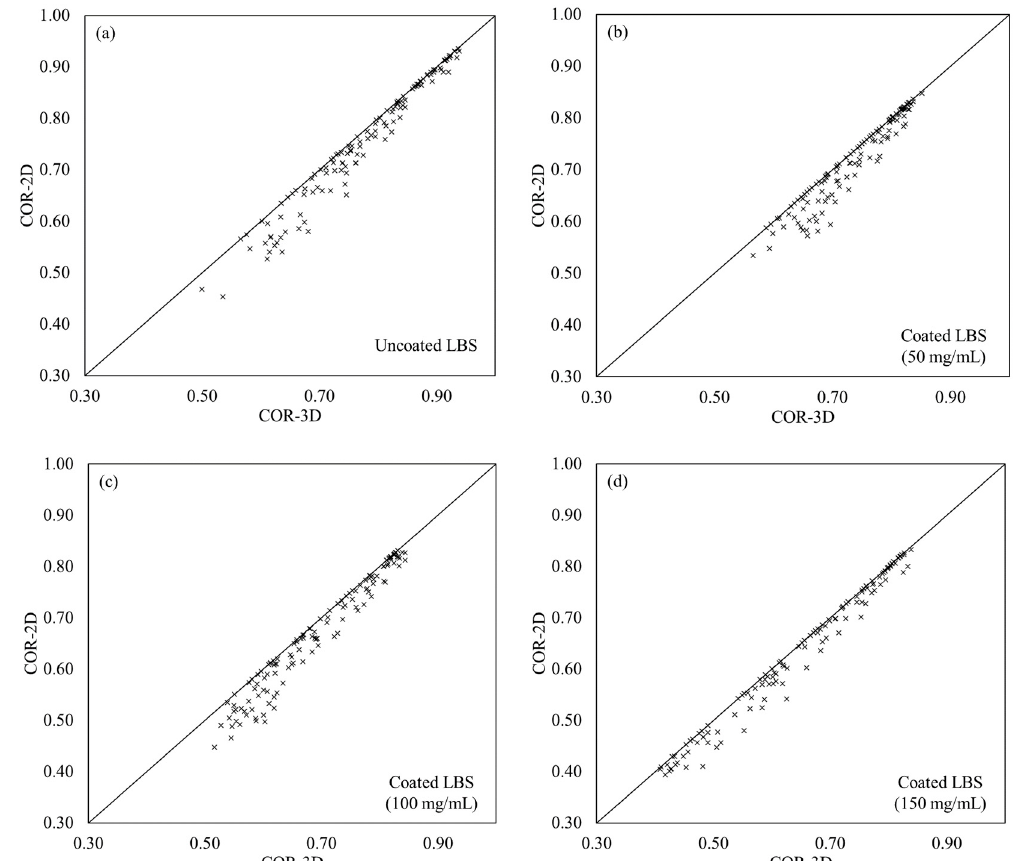
Figure 8. COR values calculated in 2D measurements against COR values calculated in 3D measurements for ( a ) uncoated LBS, and coated LBS at ( b ) 50 mg/mL, ( c ) 100 mg/mL, and ( d ) 150 mg/mL. Table 1. Basic results from the impact tests of pure LBS and coated LBS against granitic block (mean grain size = 3 mm, impact velocity = 2.42 m/s).